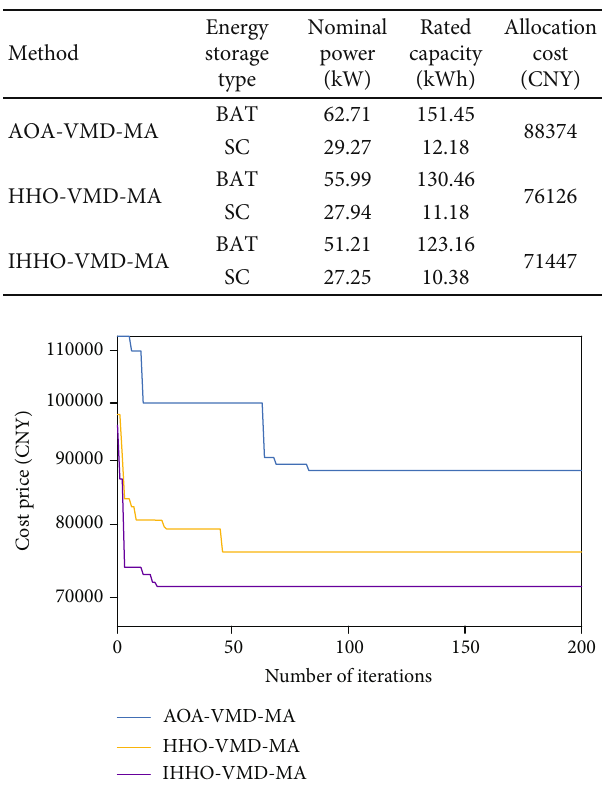
Figure 13: Convergence curves of di ff erent methods.